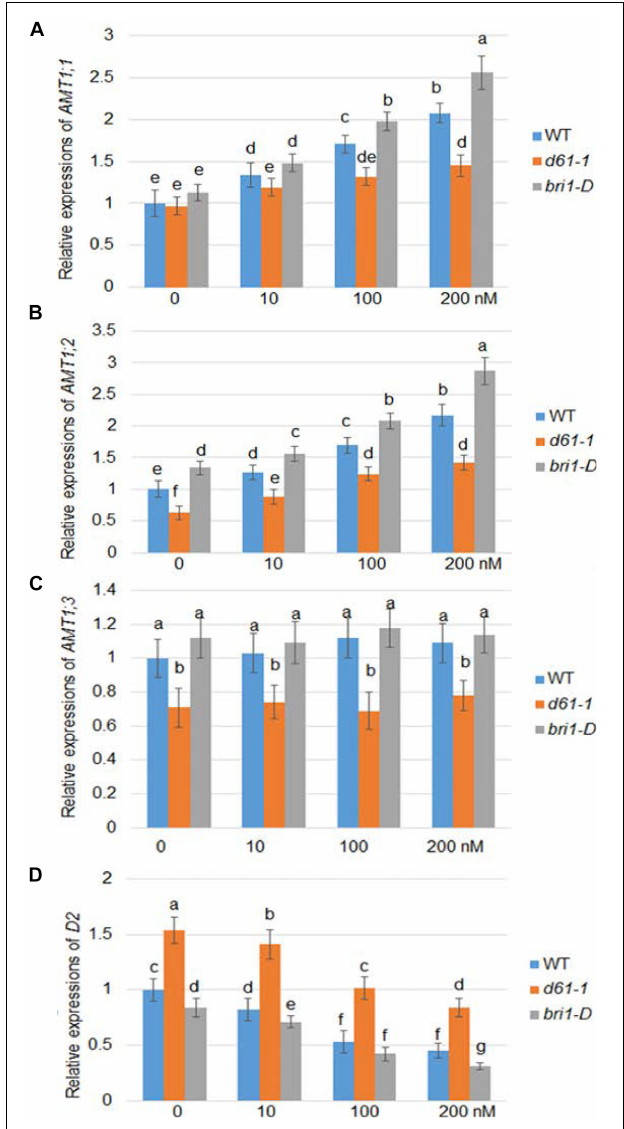
FIGURE 1 | BR-dependent AMT1 expression in wild-type, BRI1 mutant d61-1 , and BRI1 overexpression line bri1-D plant roots. Rice plants were grown for 7 days in distilled water, followed by 3 h with 0, 10, 100, or 200 nM brassinolide (BL). The expression levels of AMT1 1 (A) , AMT1 2 (B) , AMT1 3 (C) , and D2 (D) in plants treated with BL was measured by qRT-PCR using Ubiquitin to normalize the expression of each gene. Error bars indicate means ± SE ( n = 3). The experiments were repeated at least three times. Different letters represent statistically significant differences ( P <